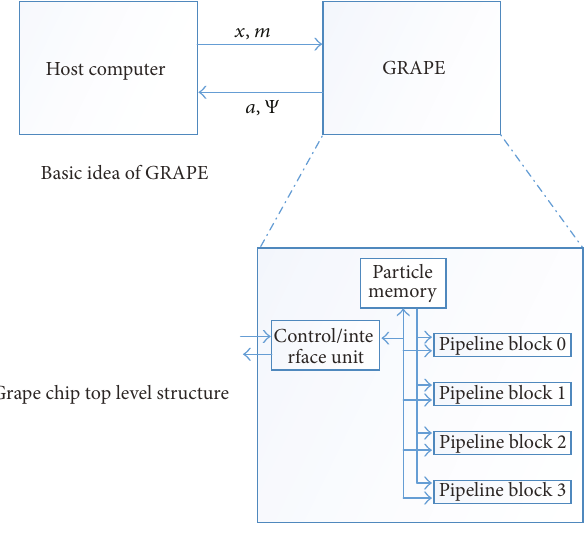
Figure 1: Basic idea of GRAPE and its top-level structure.